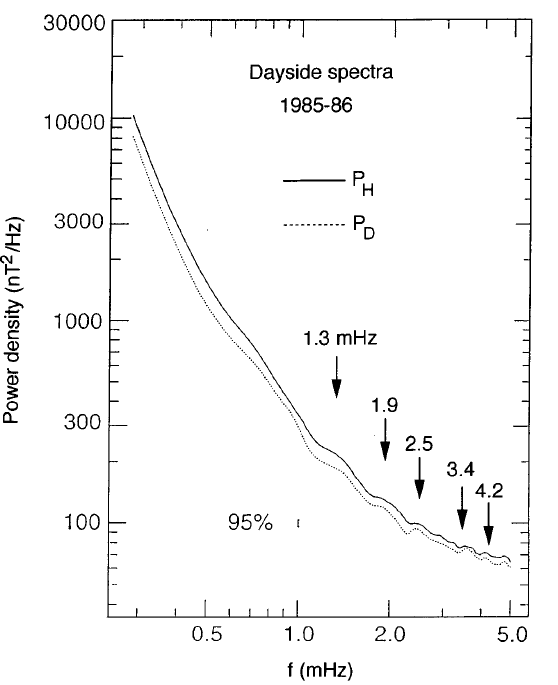
Fig. 3. An example of average power spectra for the horizontal (H and D) components of the magnetic field measured at a low-latitude ( L (cid:136) 1.6) ground station (adapted from Fig. 1a of Francia and Villante, 1997). The arrows indicate the discrete frequencies observed by high-latitude radar and attributed to wave guides modes